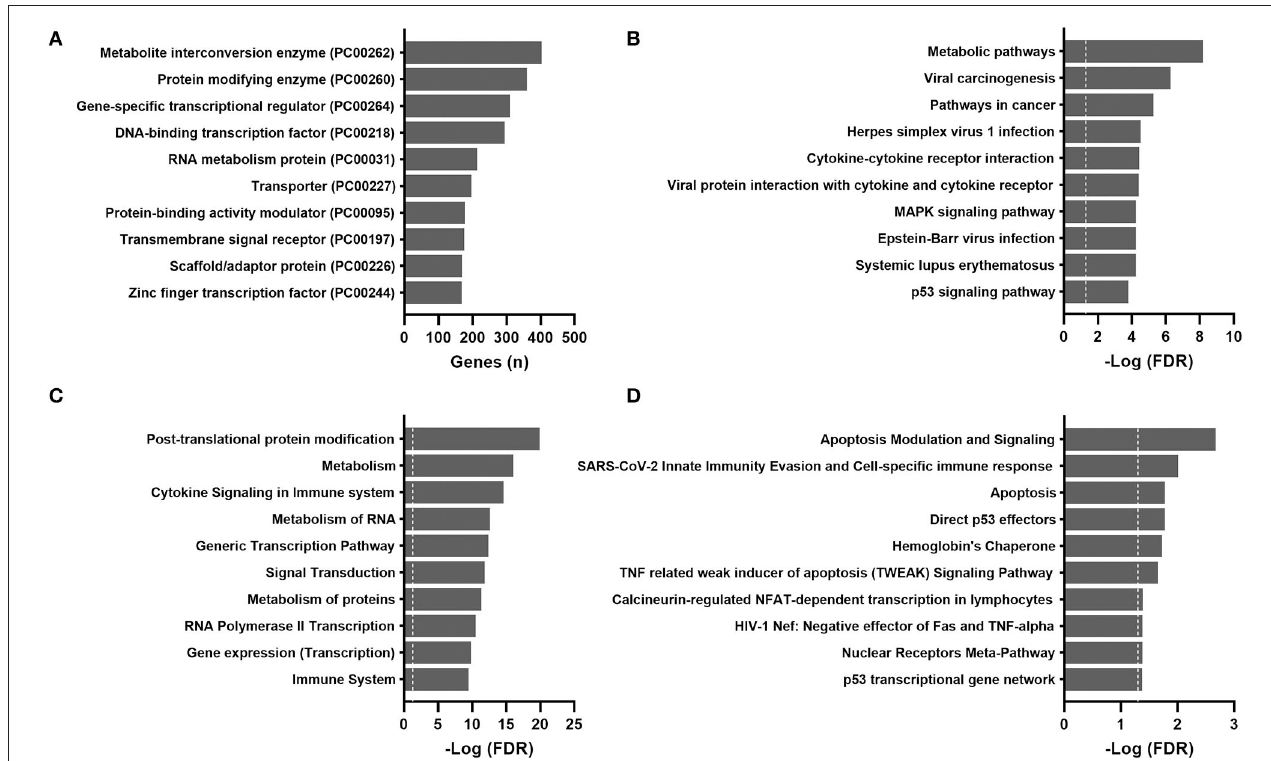
FIGURE 3 | Over-representation pathway analysis of aging-correlated genes in the GTEx dataset: (A) PANTHER protein class, (B) KEGG, (C) Reactome, and (D) BioCarta. The top 10 classes or pathways are listed. Values above the dashed line represent significant enrichment (5% level of significance). FDR, false discovery